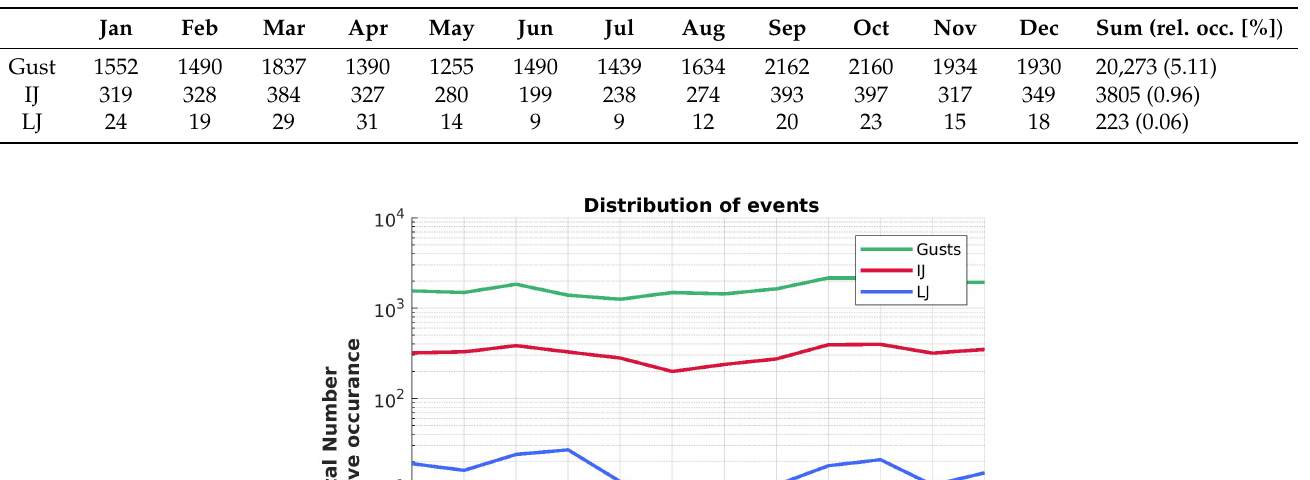
Table 2. Absolute number of LJ according to their season for the years 2013–2021. These numbers are plotted in Figure 10. The relative occurrence (rel. occ.) compared to the total amount of individual wind profiles of the three types is also given.